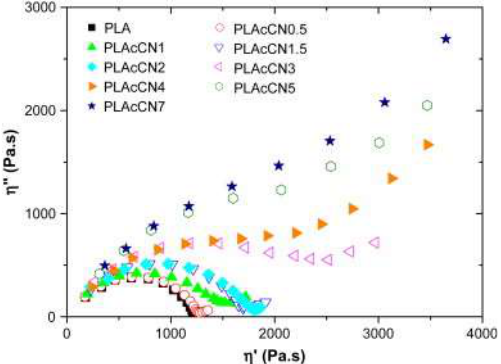
Figure 8. Cole–Cole plot for polylactide (PLA) and carboxylic functionalized